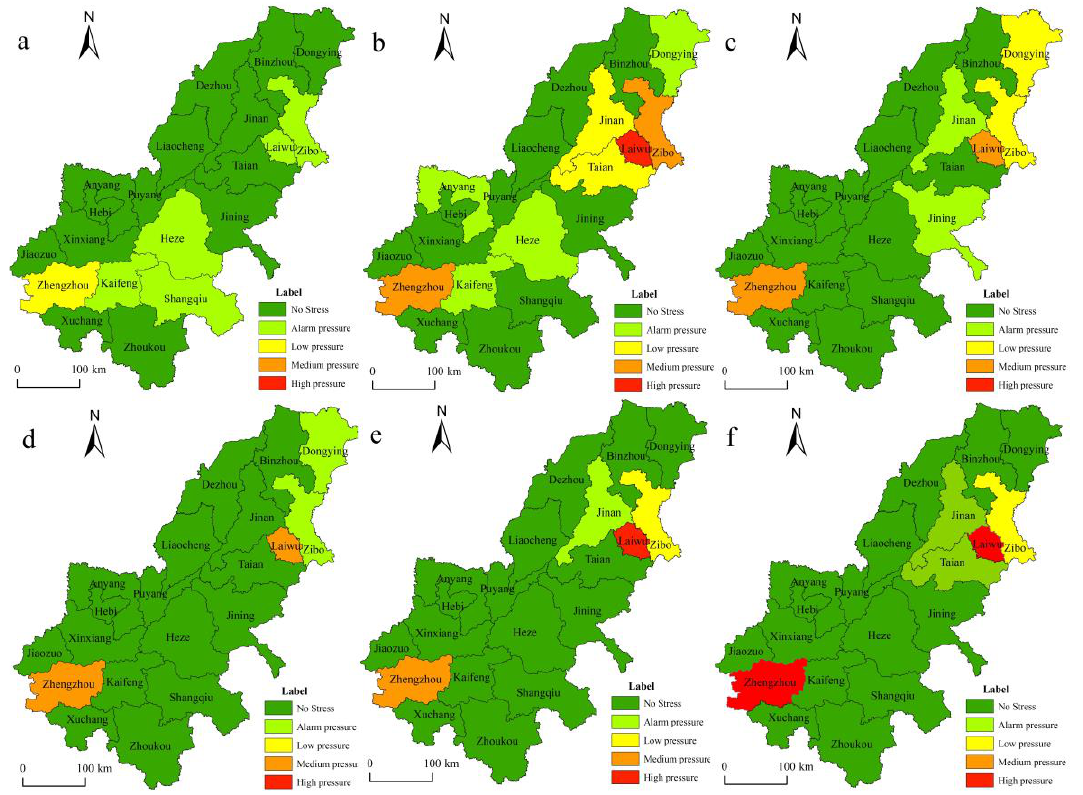
Figure 3. Spatial evolution of the CLP index. (Note: ( a – f ) in the figure represents 1998, 2002, 2006, 2010, 2014 and 2018, respectively.)